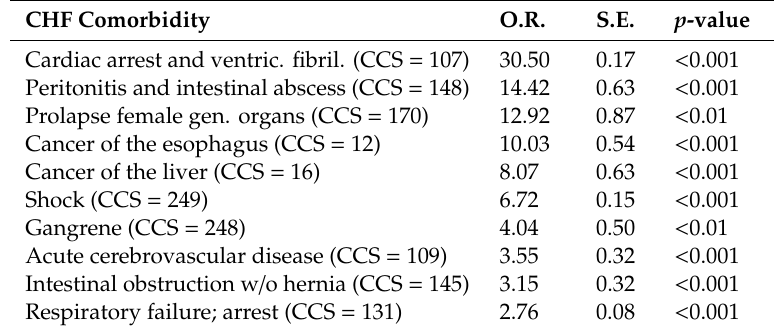
Table 4. Coe ffi cient analysis of mortality rate using binary logistic regression. The table presents the top ten comorbidities associated with the highest odds for hospital